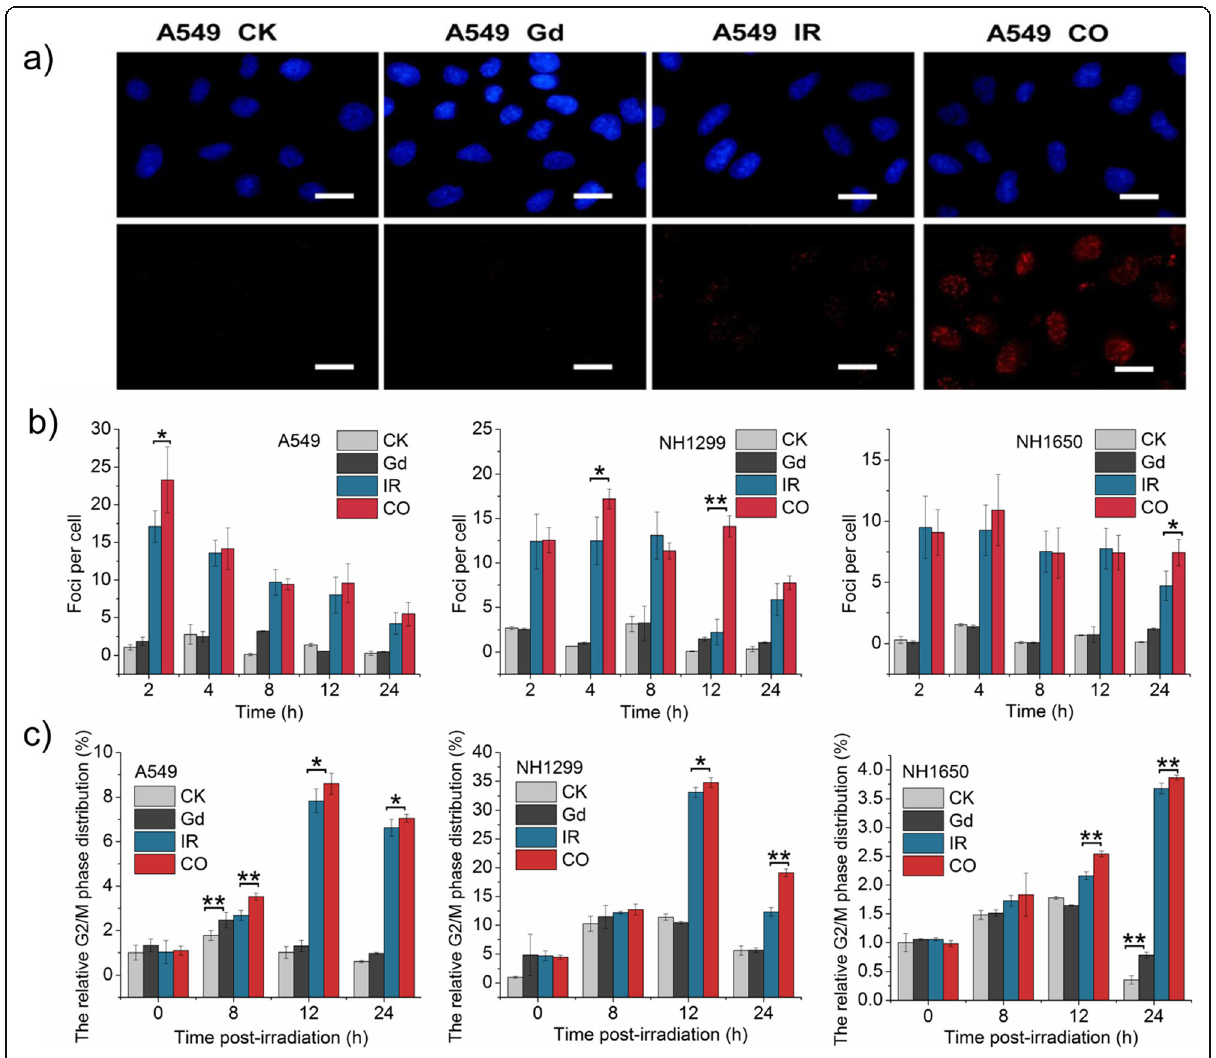
Fig. 4 GONs enhanced the number of DNA double-strand breaks and extent of cell cycle arrest. a Fluorescent images of γ -H2AX foci in A549 cells were captured with a fluorescence microscope 2 h after radiation; scale bar is 20 μ m; the nuclei stained with Hochest33342 are blue; the γ - H2AX foci visualized by incubating with fluorescent antibodies are red. b The numbers of foci per cell were counted over at least 50 cells. c The relative percentage of cells distributed in G2/M phase of cell cycle progression. * p < 0.05 or ** p < 0.01 represent statistically significant or extremely significant differences,